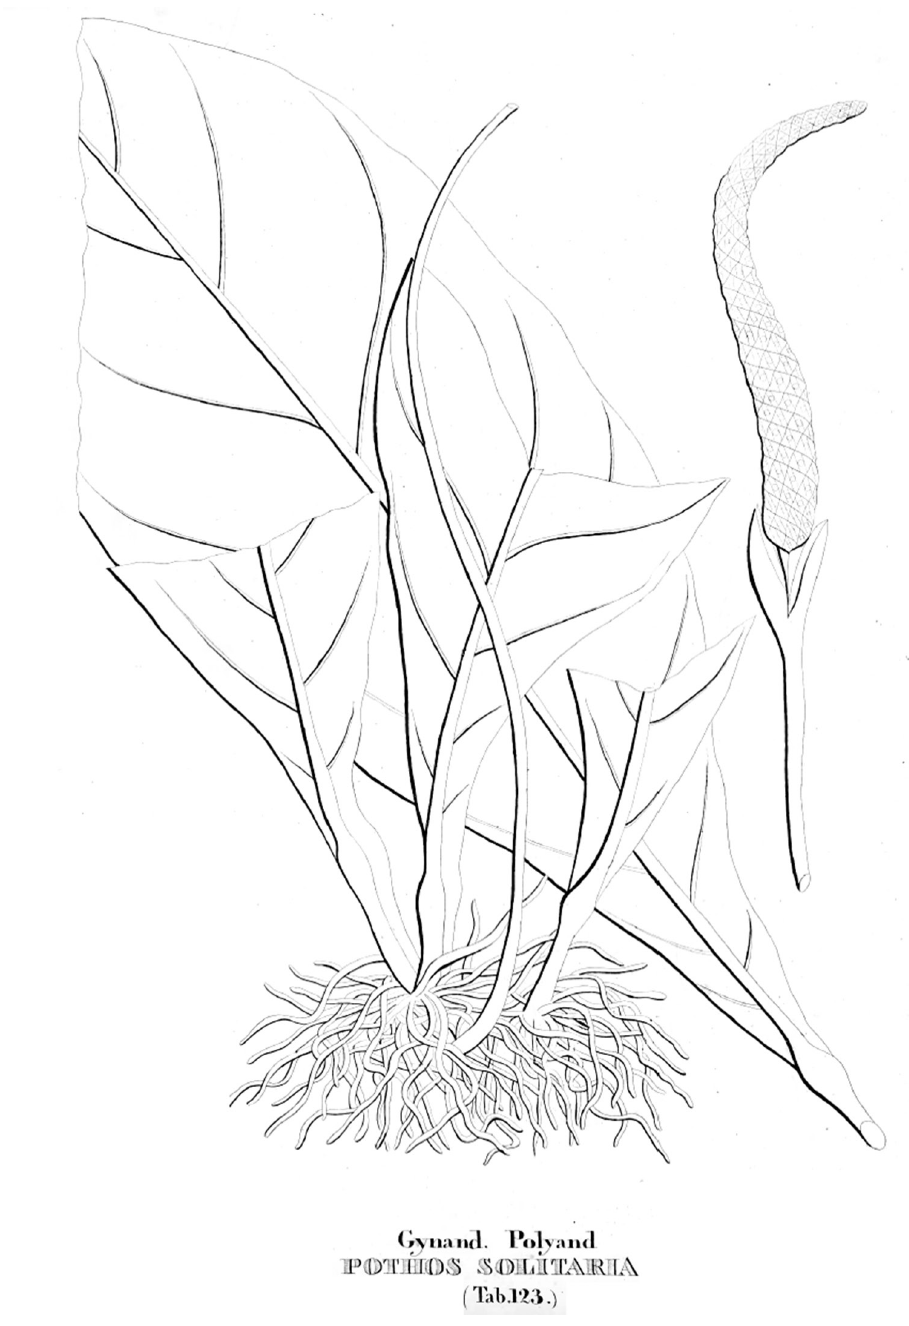
Figure 3. Lectotype of Anthurium solitarium (Garamond Pothos solitarius ), the illustration “Pothos soli- taria” in Vell., Fl. Flum. t. 123.